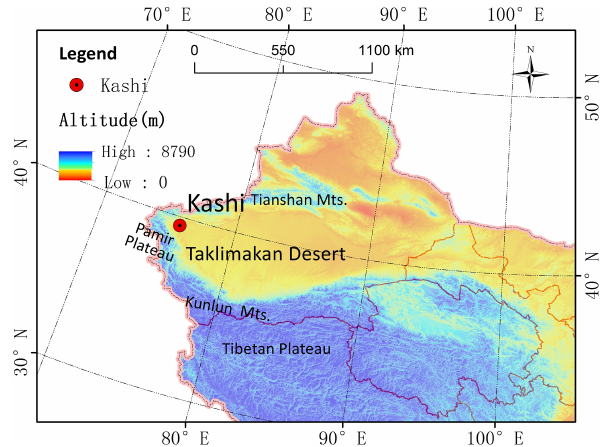
Figure 1. The location of the observation site (Kashi) of the DAO-K field